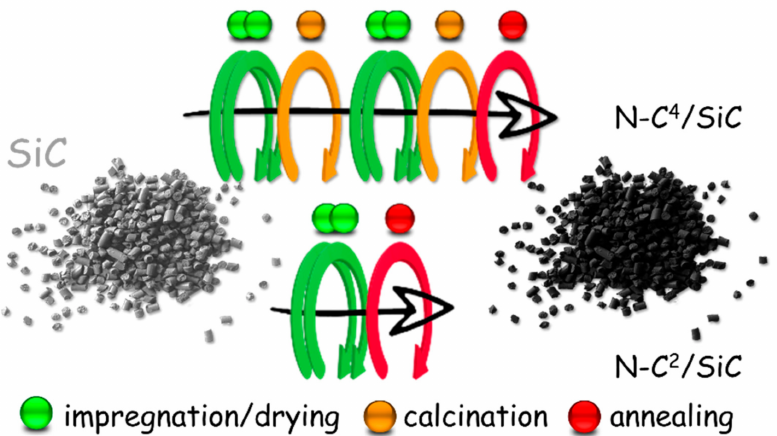
Figure 1. Quick visual representation of the two alternative synthetic paths used for the preparation of N-C 4 /SiC (upper black arrow) and N-C 2 /SiC (down black arrow) composites, respectively. Green cycles refer to the impregnation/drying steps, orange cycles refer to the material calcination at 400 ◦ C for 2 h and red cycles refer to the material annealing at 900 ◦ C for 2 h under Argon